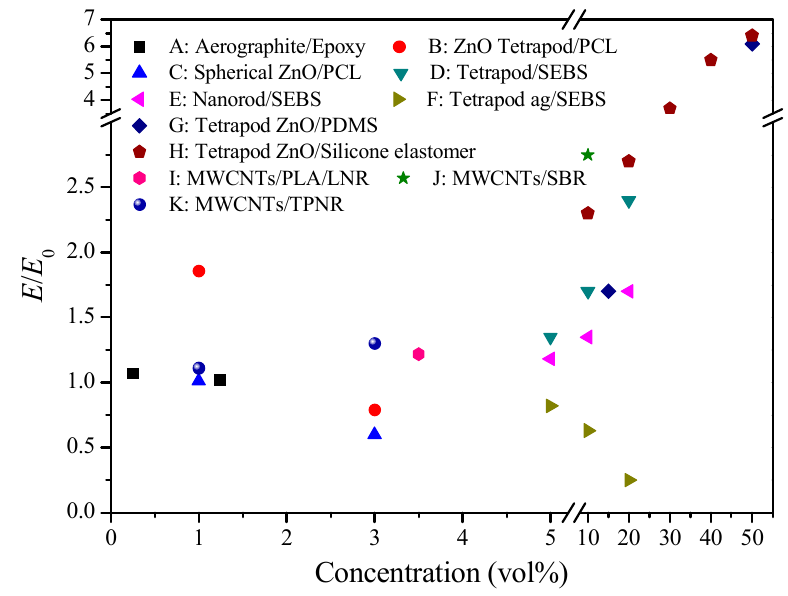
Figure 7. Plot of relative elastic modulus versus nanoparticle concentration for various nanocomposites. ( A ) the aerographite filled epoxy with particle aggregation [49]; ( B ) pristine PCL filled with tetrapod ZnO [50]; ( C ) pristine PCL filled with spherical ZnO [50]; ( D ) SEBS filled with surfaced modified CdSe/CdS tetrapod nanoparticles [44] and simulation results; ( E ) SEBS filled with surfaced modified CdSe/CdS nanorod nanoparticles [44] and simulation results; ( F ) SEBS filled with aggregated CdSe/CdS tetrapod nanoparticles [44]; ( G ) PDMS filled with tetrapod ZnO [51]; ( H ) silicone elastomer filled with tetrapod ZnO [52]; ( I ) PLA/LNR nanocomposite filled with MWCNTs [53]; ( J ) SBR nanocomposite filled with MWCNTs [54]; ( K ) TPNR nanocomposite filled with MWCNTs [55].